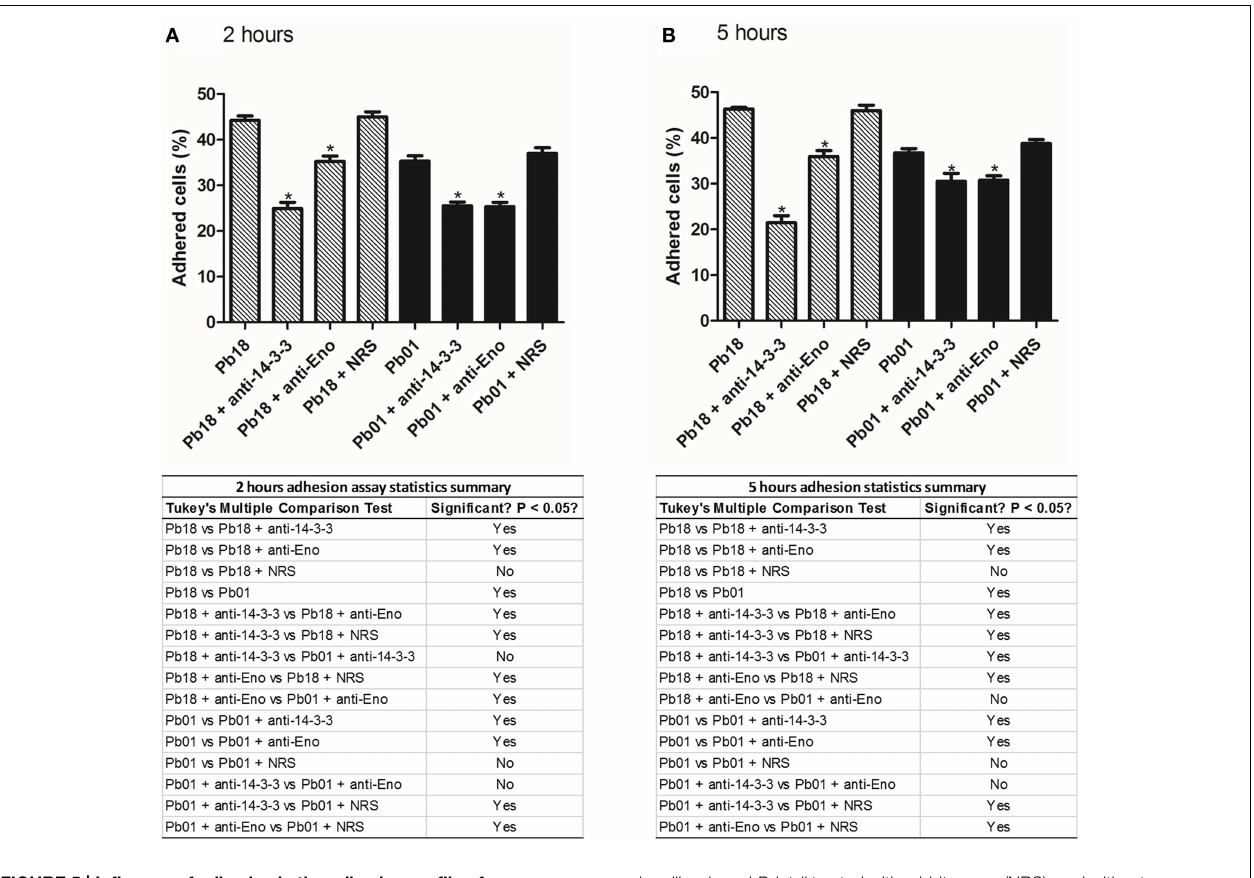
FIGURE 5 | Influence of adhesins in the adhesion profile of Paracoccidioides spp. to pneumocytes A549. Adhesion profiles of P. brasiliensis and P. lutzii treated with 14-3-3 and enolase antibodies to A549 pneumocytes after (A) 2h and (B) 5h of infection. As controls, we used P.